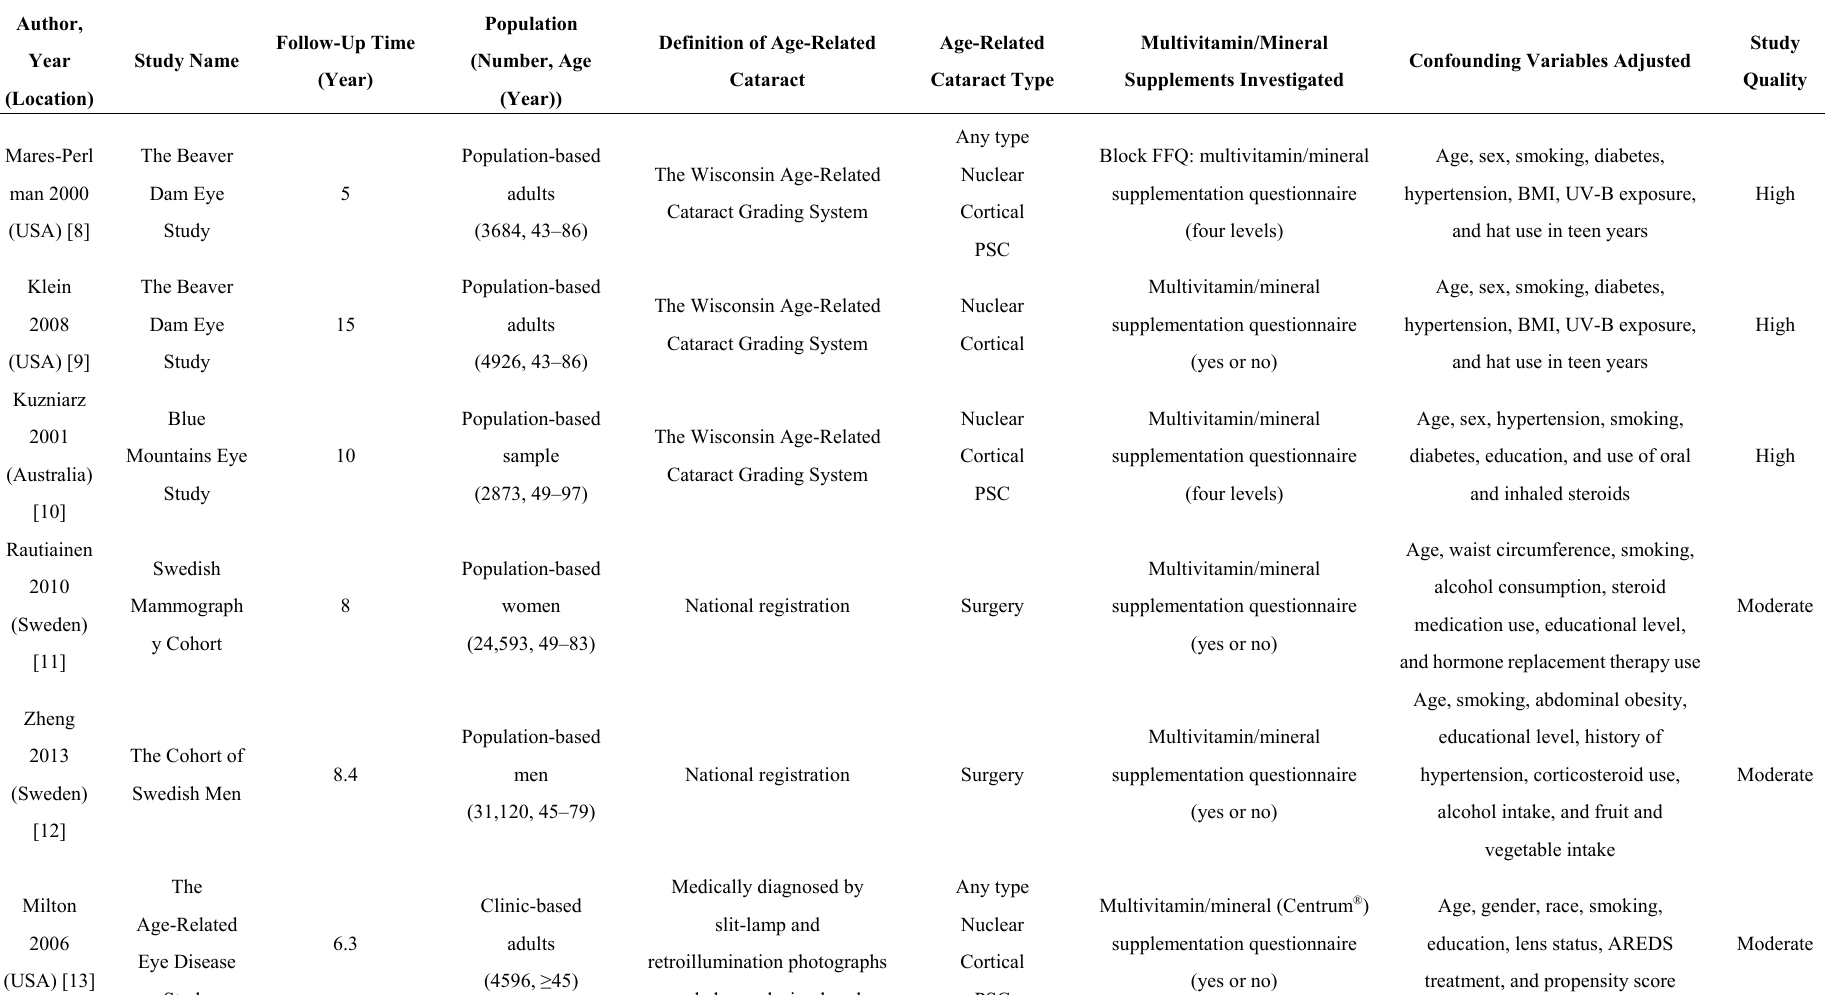
Table 1. Prospective cohort studies evaluating multivitamin/mineral supplementation and its association with the low risk of age-related